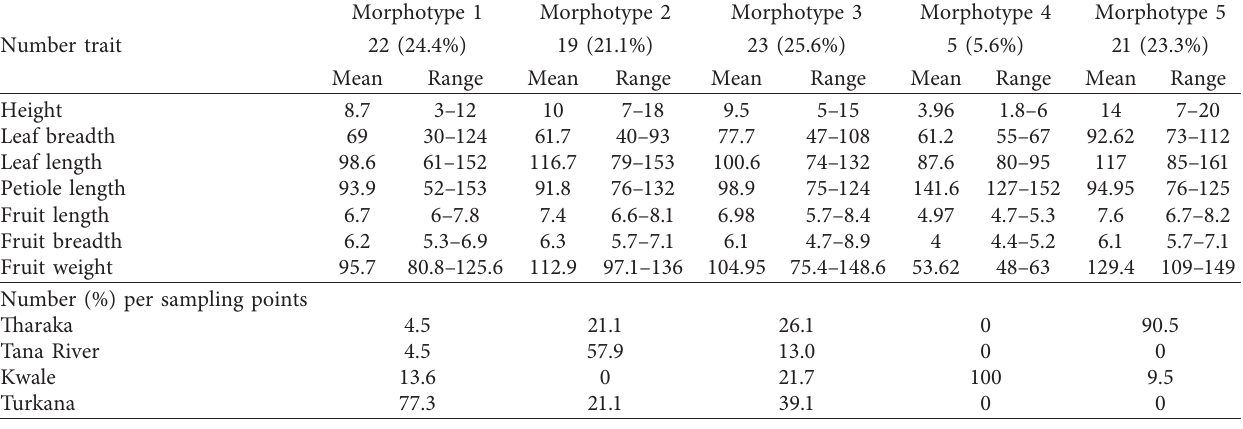
Table 9: Quantitative traits of H. compressa morphotypes from arid and semi-arid lands of Kenya.